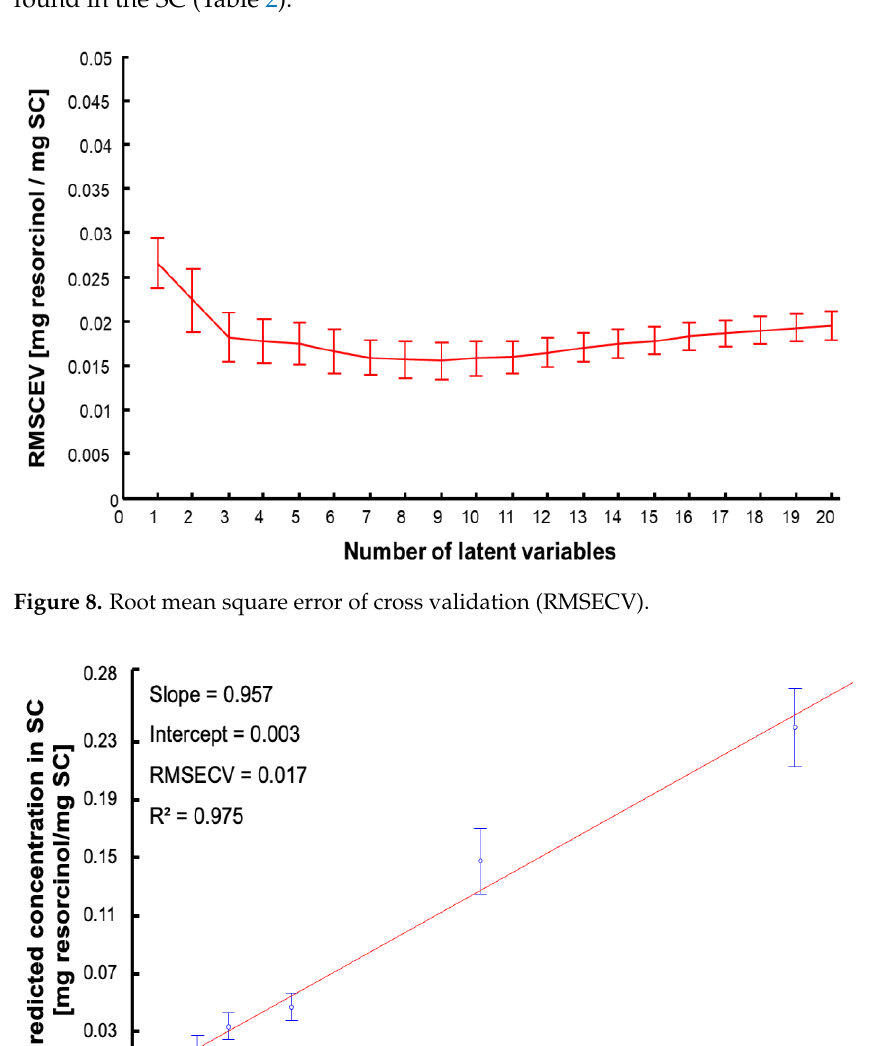
Figure 10. First regression coefficient from the PLSR analysis. The second step of PLSR is to evaluate the quantitative performances of the PLSR model with a test set. For this purpose, 1/4 of the Raman maps analysed for each SC sam- ple was kept independent and projected in the predictive models as unknown samples to be determined. As described in Section 2.3, the samples in the test set are also prepared by immersion and hence their concentration is known; these values are not used during the training of PLSR model in order not to bias the analysis, but rather at the later stage to assess the performance of the model based on the RMSEP and R 2 . The PLSR plot obtained from the test set is presented in Figure 11. The linear regression gives an equation Y = 1.009·X + 0.003 and a R 2 = 0.971. The RMSEP = 0.015 mg resorcinol/mg SC corresponds to 11.67% compared to the median concentration of the range studied.